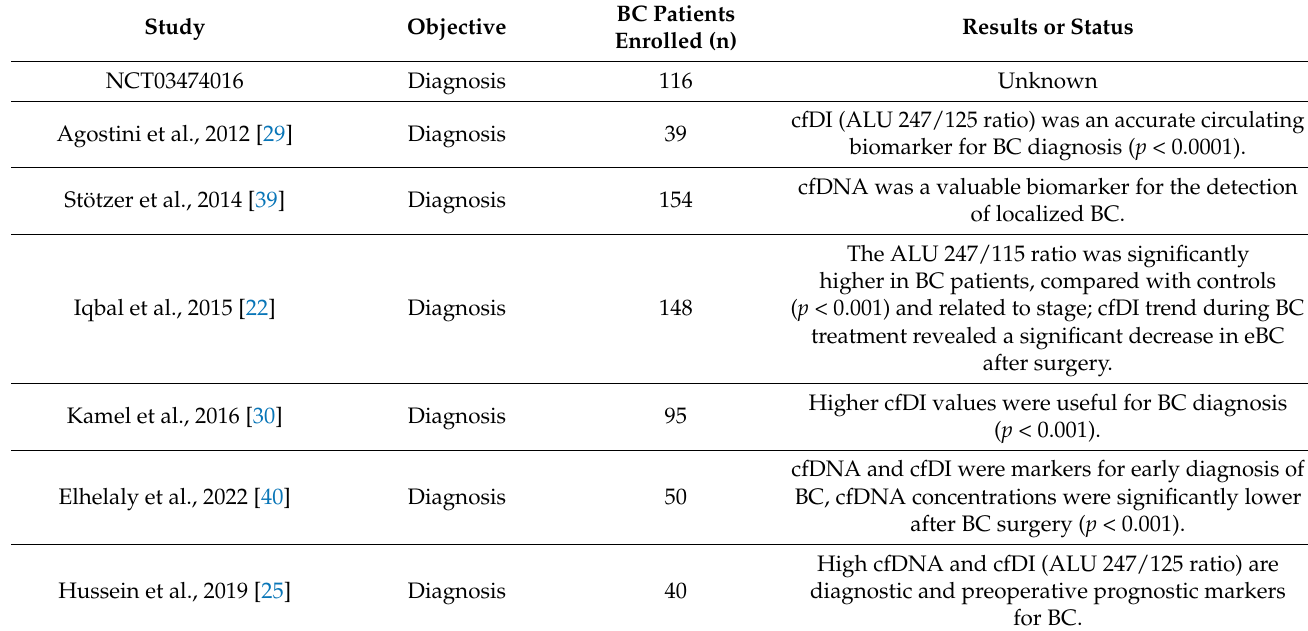
Table 1. Studies conducted into fragment size and cfDI in BC with qPCR